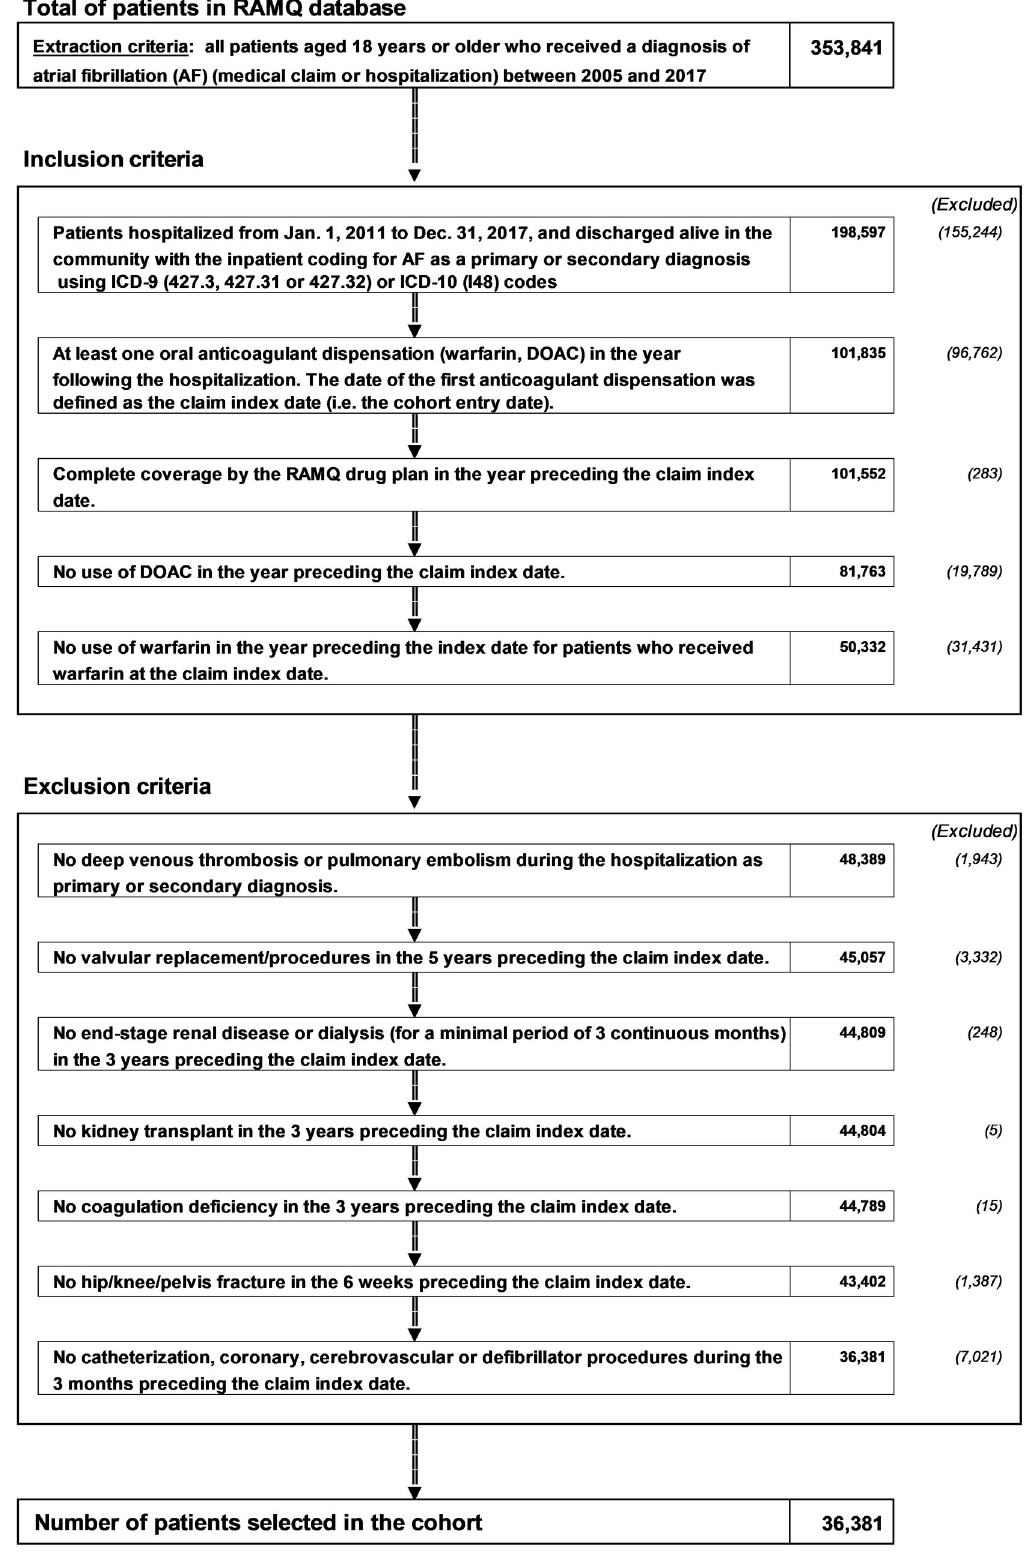
Fig 1. Population-based cohort definition flowchart. AF: atrial fibrillation; OAC: oral anticoagulant, DOAC: direct oral anticoagulant, RAMQ: Re´gie d’Assurance-Maladie du Que´bec.